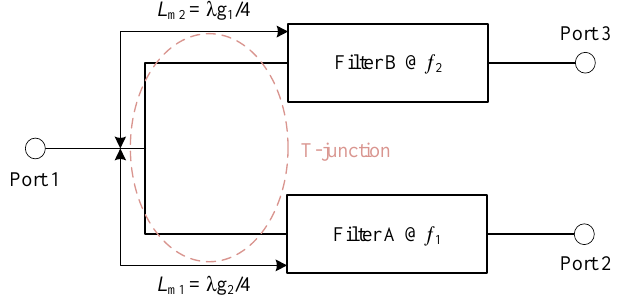
Figure 1. Schematic diagram of the T-junction